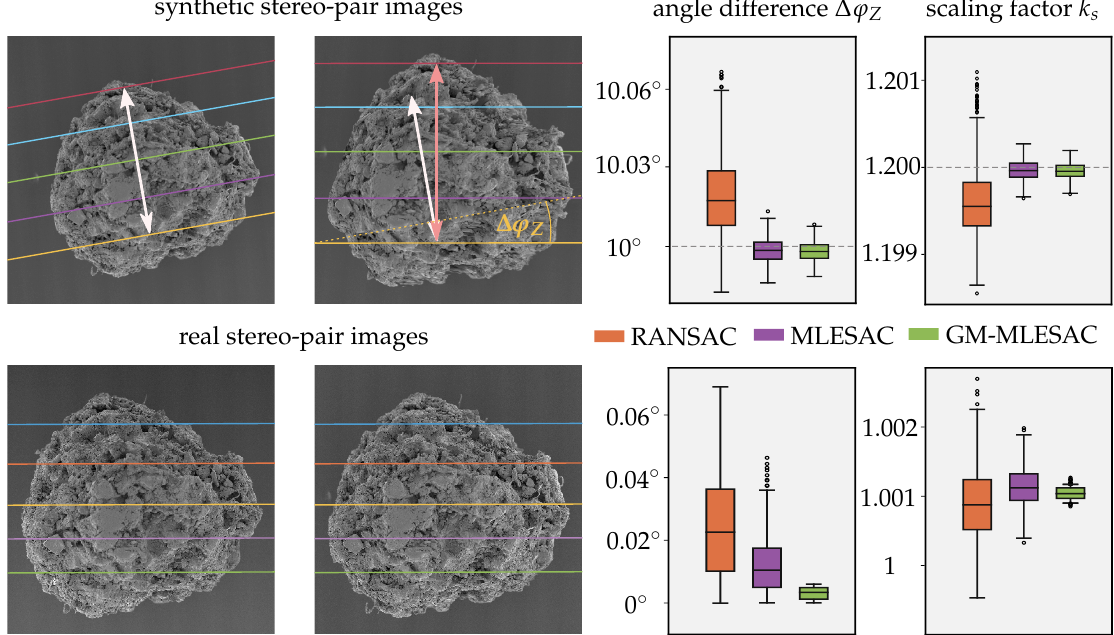
Figure 5. Synthetic and real stereo-pair of a gravel particle. Computation of the relative scaling factor k s and the angle difference ∆ ϕ Z = ϕ Z ,1 − ϕ Z ,2 using 1000 runs of the robust estimation schemes with 500 subsamples each. Rotation angles for the synthetic pair were set to ∆ ϕ X = 0 ◦ , ∆ ϕ Y = 10 ◦ , ∆ ϕ Z = 10 ◦ and the relative scaling factor to k s = 1.2. For the real images an eucentric tilting was used with ∆ ϕ = 10 ◦ Y